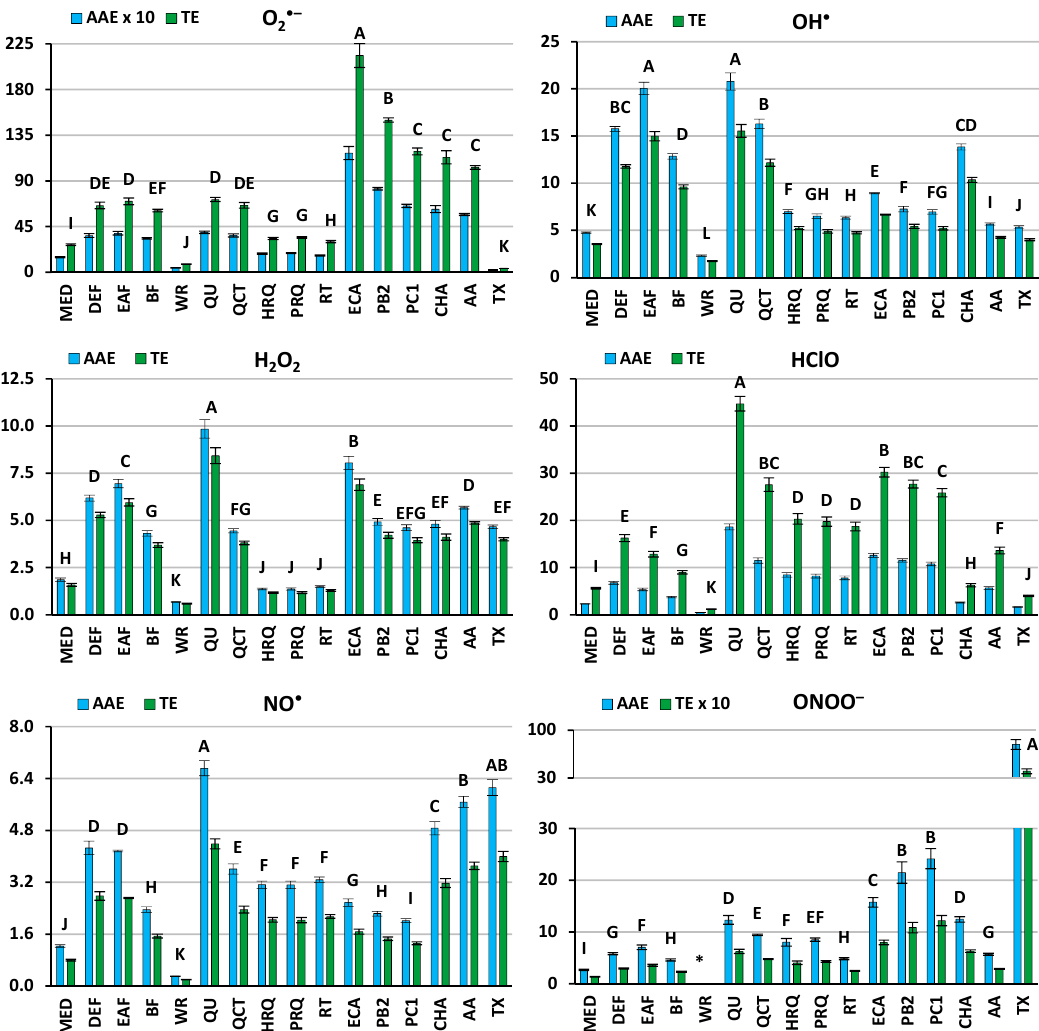
Figure 3. Antioxidant activity of S. domestica leaf extracts, their activity markers and standards towards in vivo-relevant oxidants. Results are expressed in micromolar equivalents of ascorbic acid (AA) and Trolox (TX) per mg of extract/compound and presented as mean values ± SD ( n = 3). For each assay, the different letters A–K indicate significant differences ( p < 0.05). The analyte marked with an asterisk was inactive in concentrations up to 200 µg/mL. For extracts and analyte codes, see Figure 1 and Figure 2.